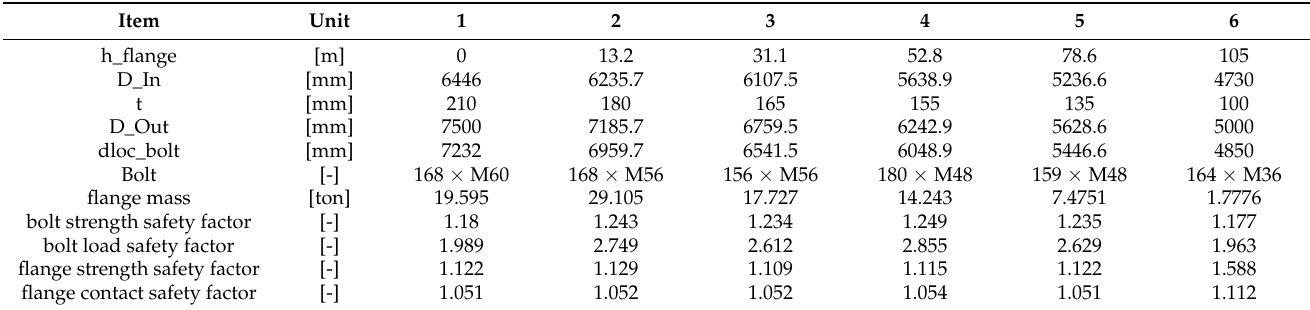
Table 6. Parameters and safety factors of bolted connections.